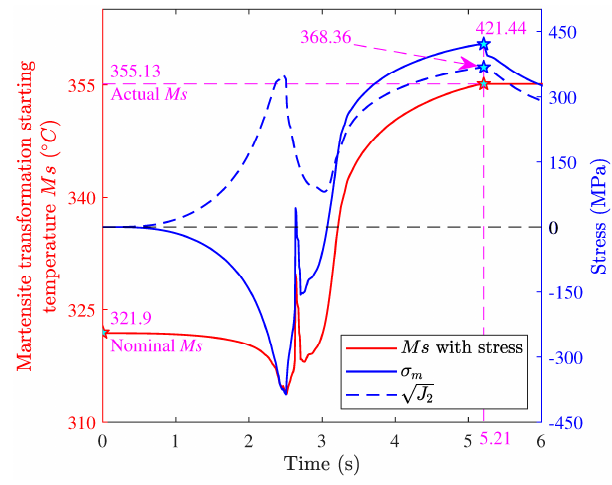
√ J 2 histories, and Ms with J histories, and Ms with stress. Figure 11. Hydrostatic stress and 2 J histories, and Ms with stress. 2